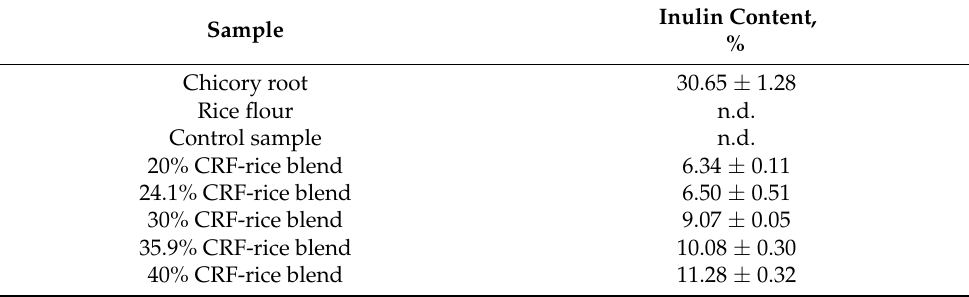
Table 3. Inulin content (%) in raw materials, starting blends and control